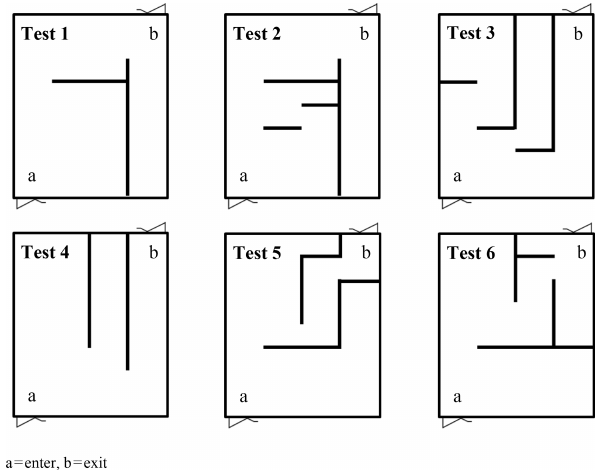
Figure 1. Maze learning ability tests.